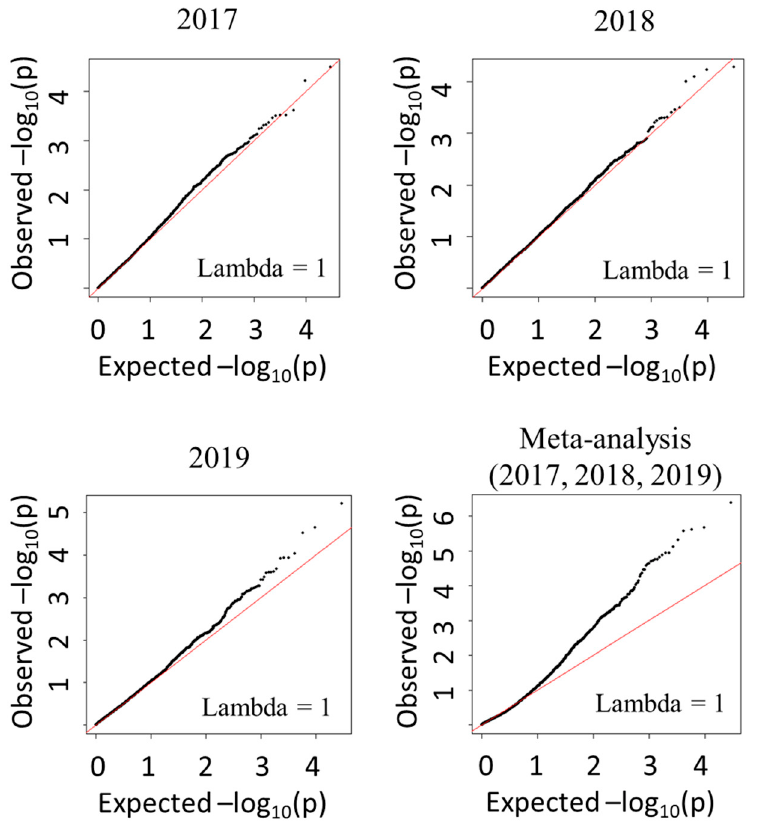
Figure 5. Quantile-quantile plots for − log 10 ( p ) for 2017, 2018, 2019, and meta-analysis data. Standard GWAS analysis was performed with phosphorus content data for 2017, 2018, and 2019 crops, followed by an analysis of meta-data, united all three years’ data (Figure 6). The p -values of the most significant SNPs obtained in the meta-analysis are presented